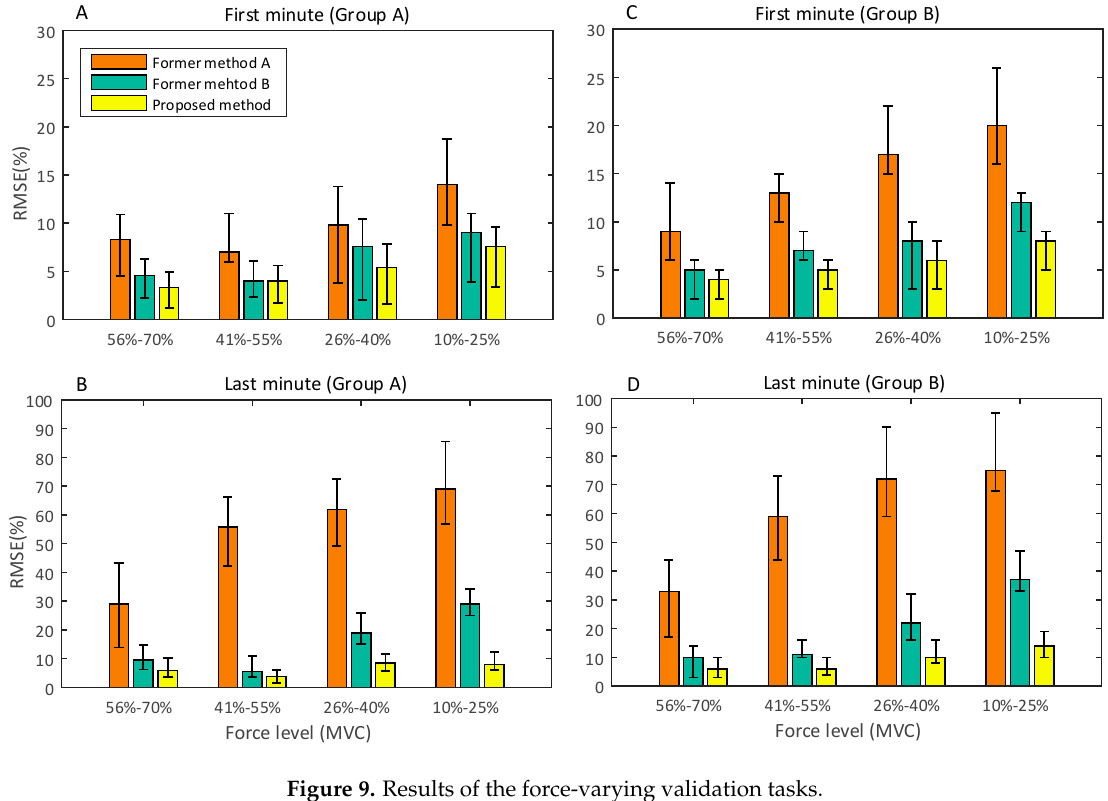
Figure 9. Results of the force-varying validation tasks.